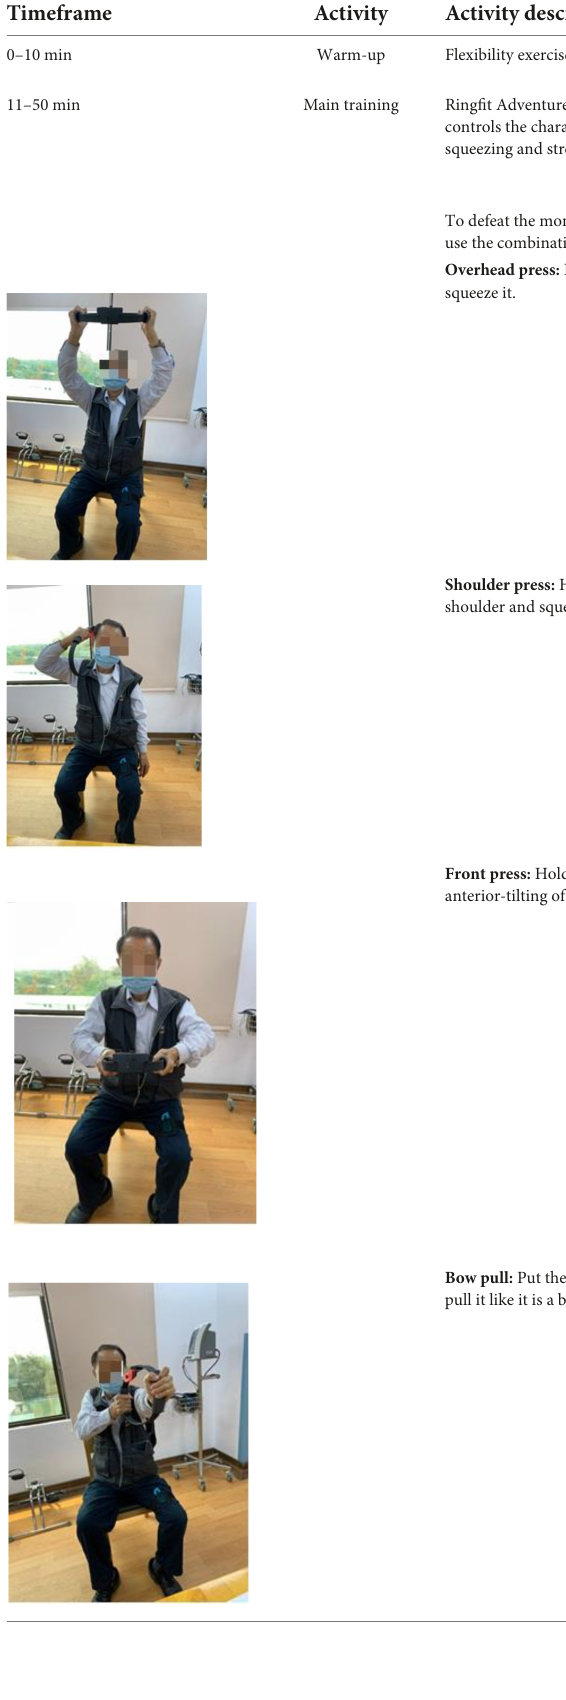
Ringfit Adventure with knee assist mode. The player controls the character in the Adventure Mode by squeezing and stretching the Ring-Con. Overheadpress: Hold the Ring-Con overhead and squeeze it.